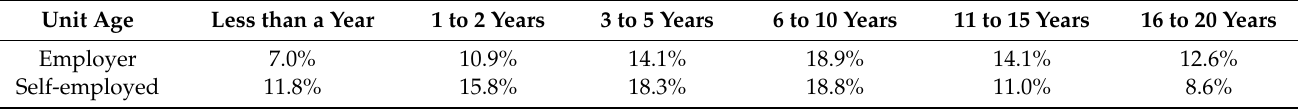
Table 8. Starting unit age for self-employed and employer led